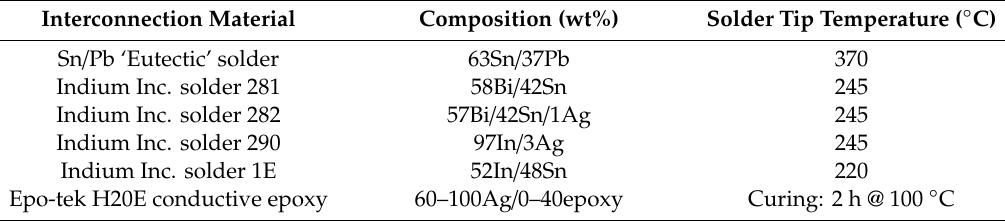
Table 1. Solder and conductive epoxy composition and soldering / curing